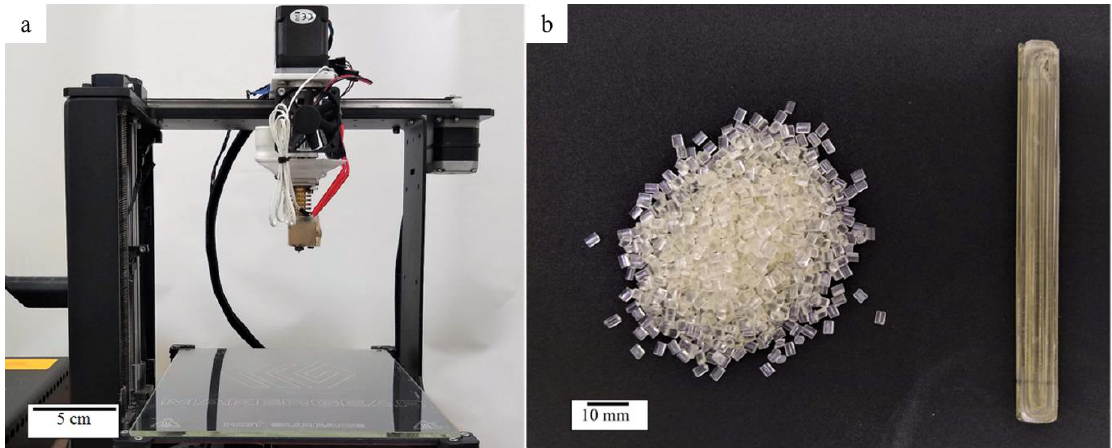
Figure 1. Instrumentation and supplies used in this work. ( a ) Universal pellet extruder mounted on the open-source Makergear M2 Printer. ( b ) Shape memory polymer (SMP) pellets used in this work ( left ) and 3D-printed SMP part ( right ).